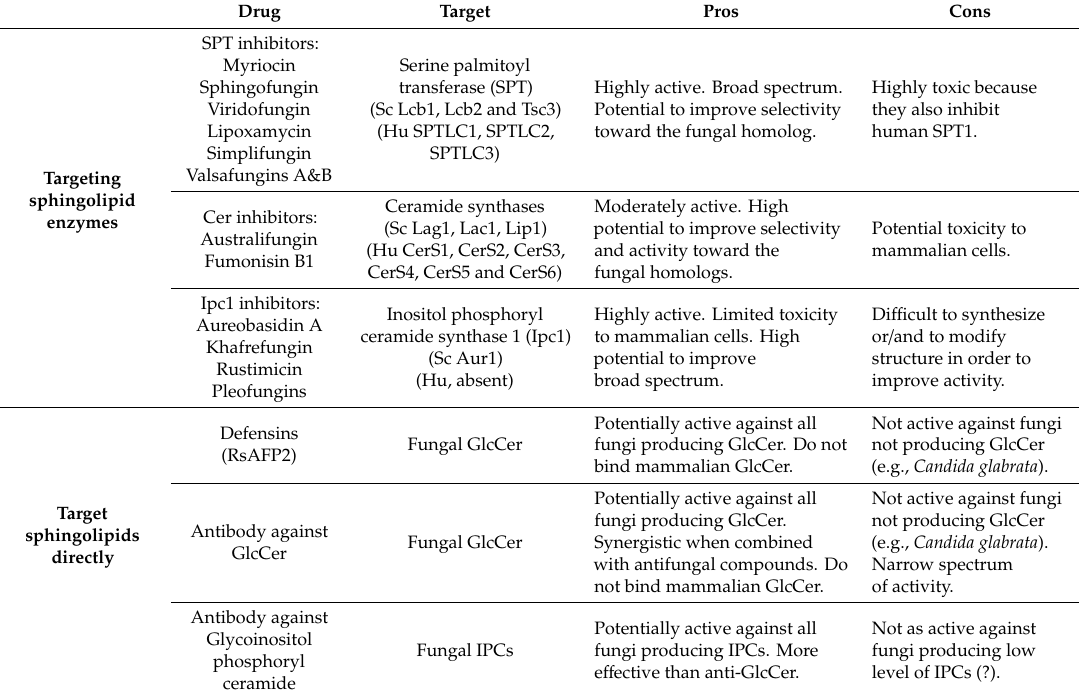
Table 1. Inhibitors of the fungal sphingolipid biosynthetic